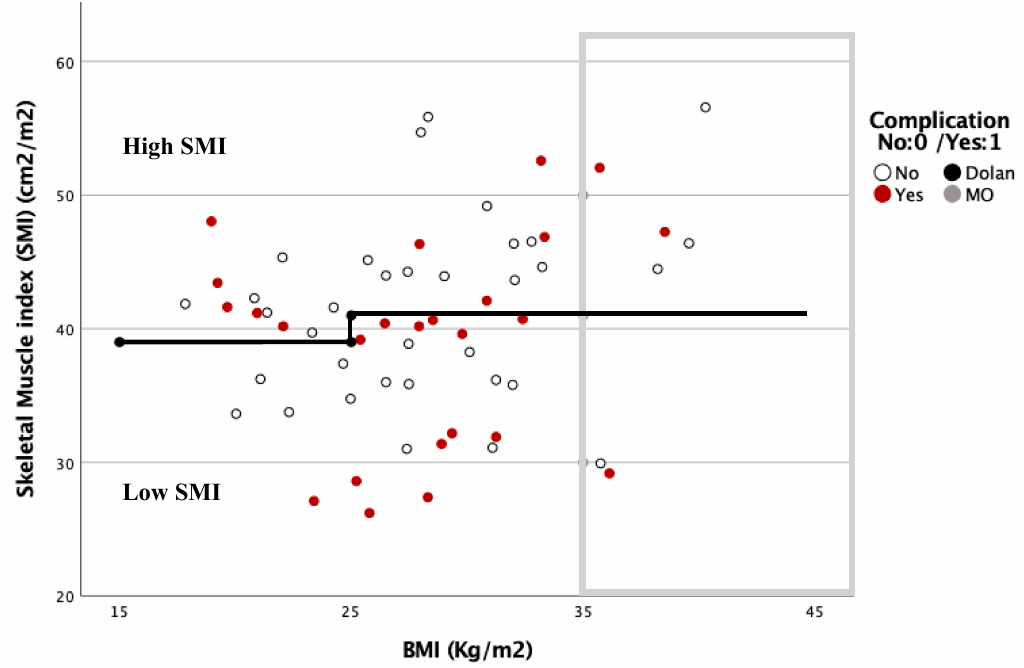
Figure 4. Dispersion diagram correlating complications between BMI and SMI in women.